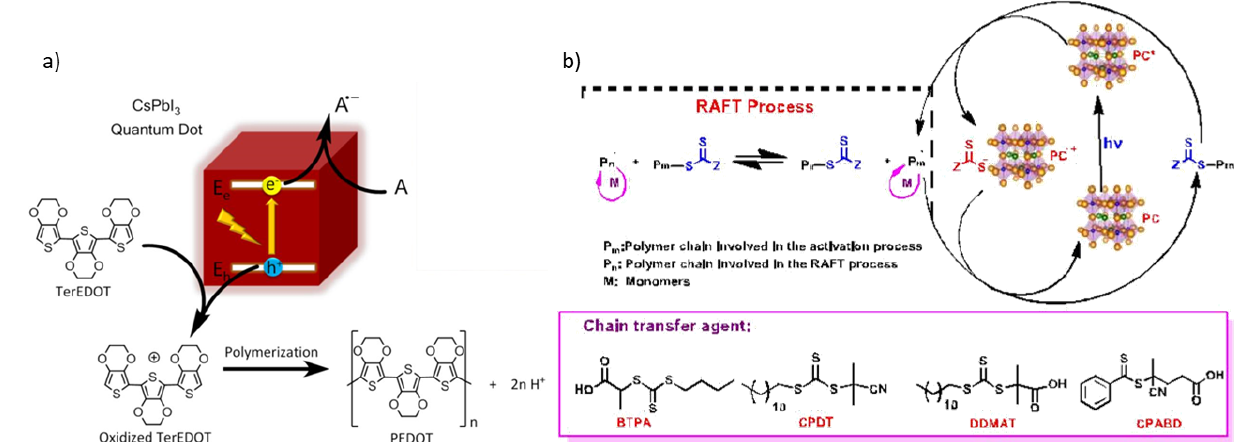
Figure 4. Proposed reaction mechanisms: ( a ) for the polymerization of TerEDOT over CsPbI 3 QD. For details, see ref. [17]. Reprinted with permission from ref [17]. Copyright 2017 Journal of the American Chemical Society, available online at: